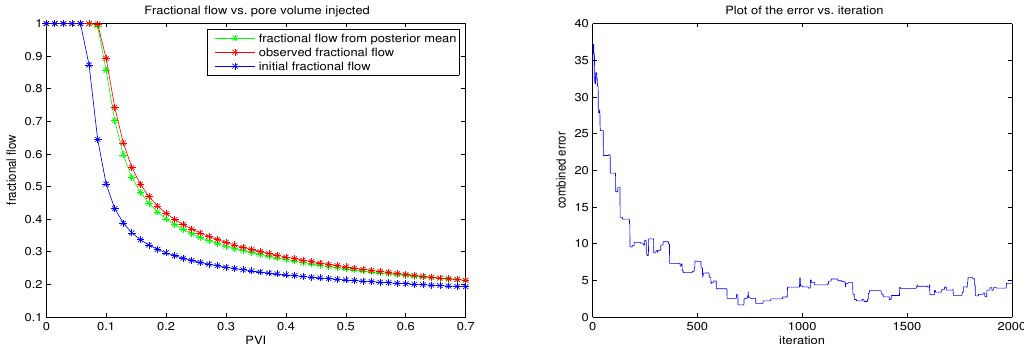
Figure 10. Left : Red line designates the fine-scale reference fractional flow of oil, the blue line designates the initial fractional flow of oil, and the green line designates fractional flow of oil corresponding to mean of the sampled permeability field from two-stage MCMC. Right : Fractional flow errors vs. accepted iterations when sampled from the posterior distribution retaining 25 terms in K-L